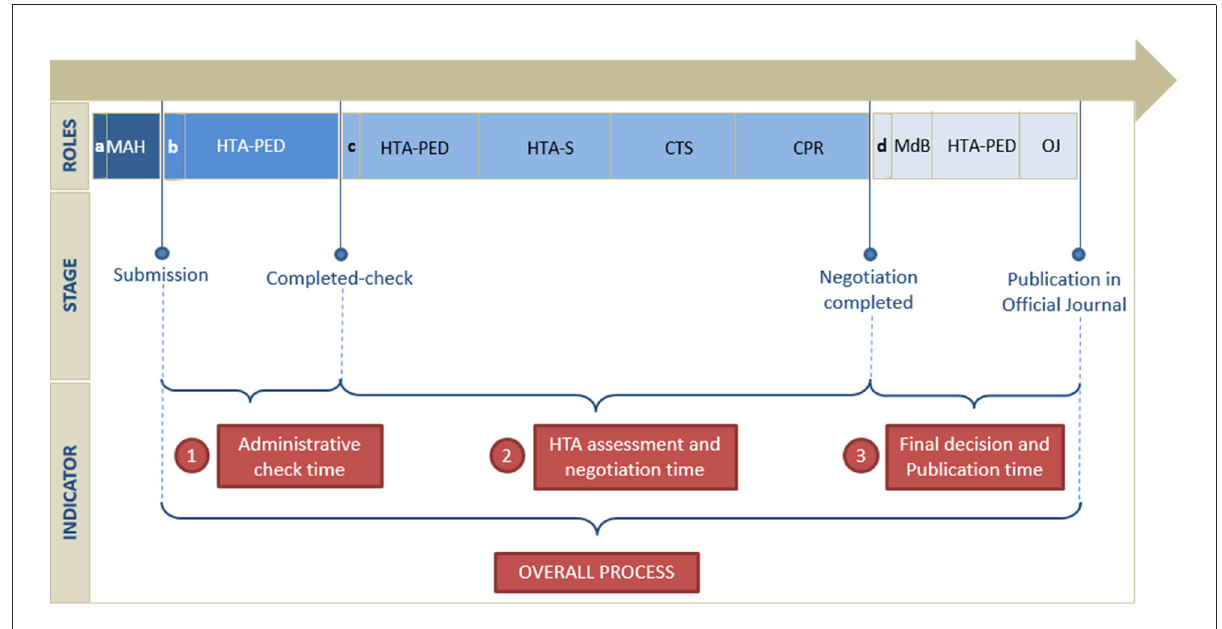
FIGURE1 Timeline of the pricing and reimbursement